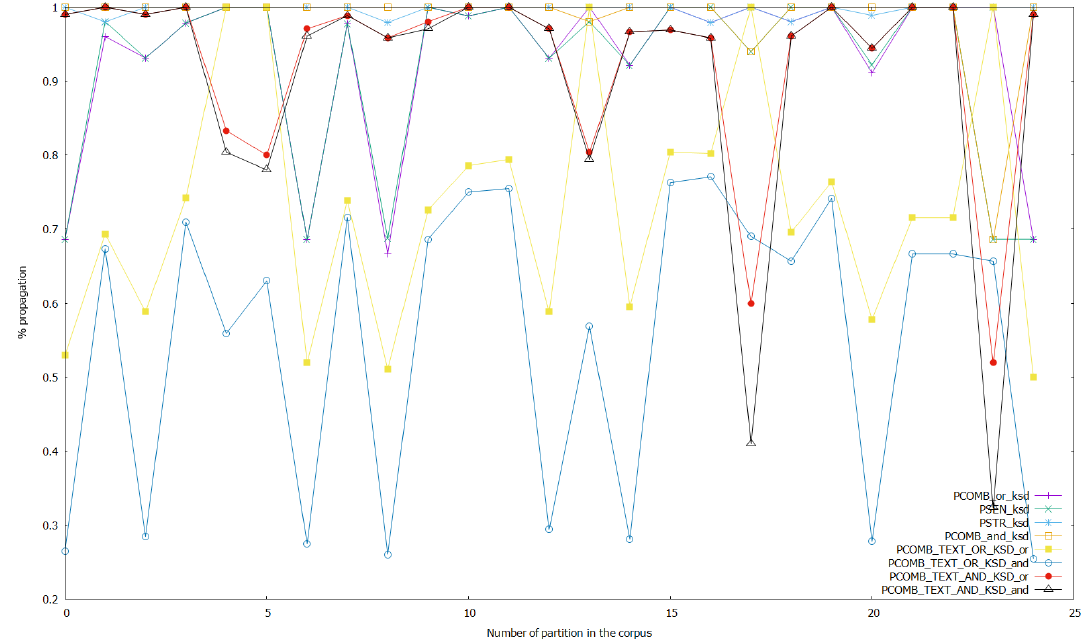
Figure 13. Results of the experiments with the sentiment, stress, and combined analyses on keystroke data, and with the combined analyses on text and keystroke data with threshold set to 0.7 in the ANNs that perform stress